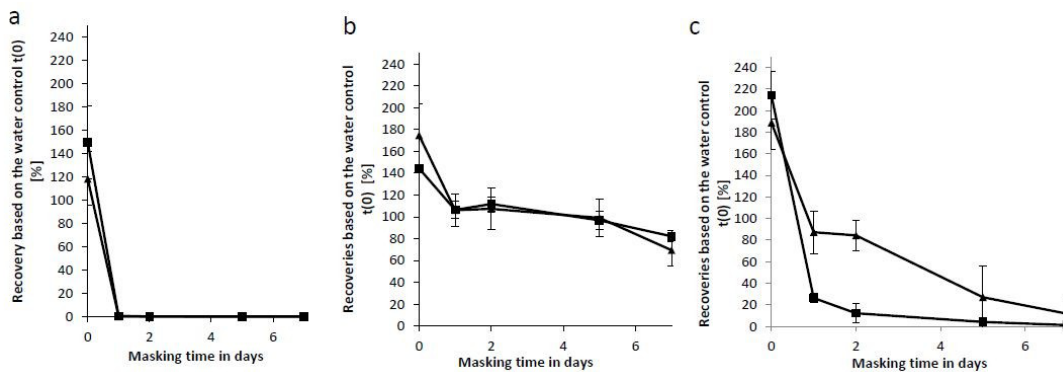
Figure 3. Masking ability of different NOEs depending on the growth condition. Endotoxin recovery was plotted as function of incubation time. 100 EU/mL endotoxin from different bacteria (( a ) E. coli O113:H21, ( b ) B. cepacia and ( c ) P. aeruginosa ) were spiked into samples containing 10 mM sodium citrate and 0.05% (w/v) polysorbate 20 and incubated at room temperature (RT). The used endotoxin extracts were derived from two different bacterial growth conditions. Squares reflect recovery of endotoxin from bacteria grown at 37 °C using 100% LB media. Triangles reflect recovery of endotoxin from bacteria grown at room temperature using 1% (v/v) LB media. Each endotoxin was prepared in triplicate. The corresponding endotoxin measurements of three repetitions were analyzed on the same microtiter plate. For calculation of the data points the mean value of the three individual preparations was used. The error bars represent the standard deviation of the three replicates.